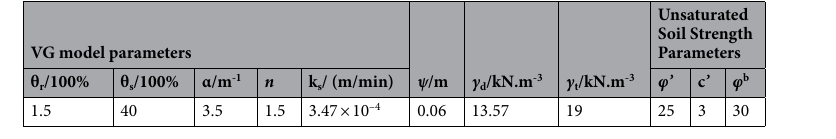
Table 1. Basic parameters of